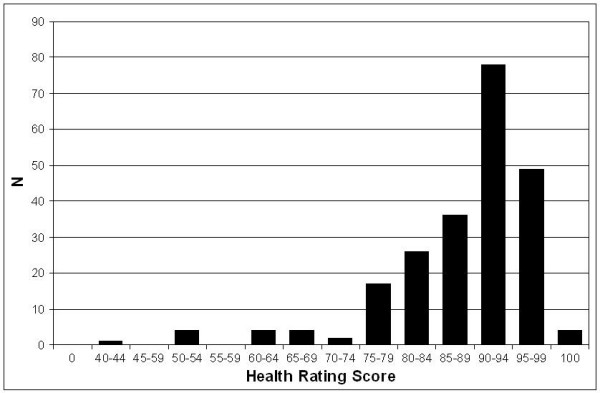
Histogram of health rating scores.